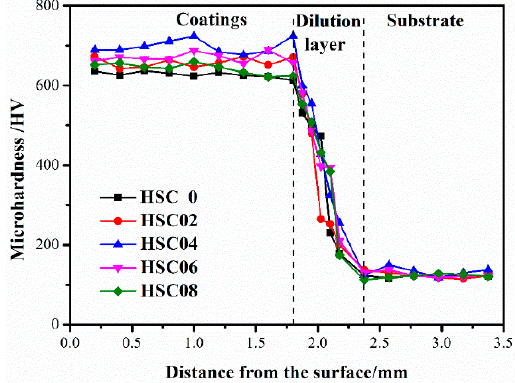
Figure 9. The microhardness distribution of the coating samples.